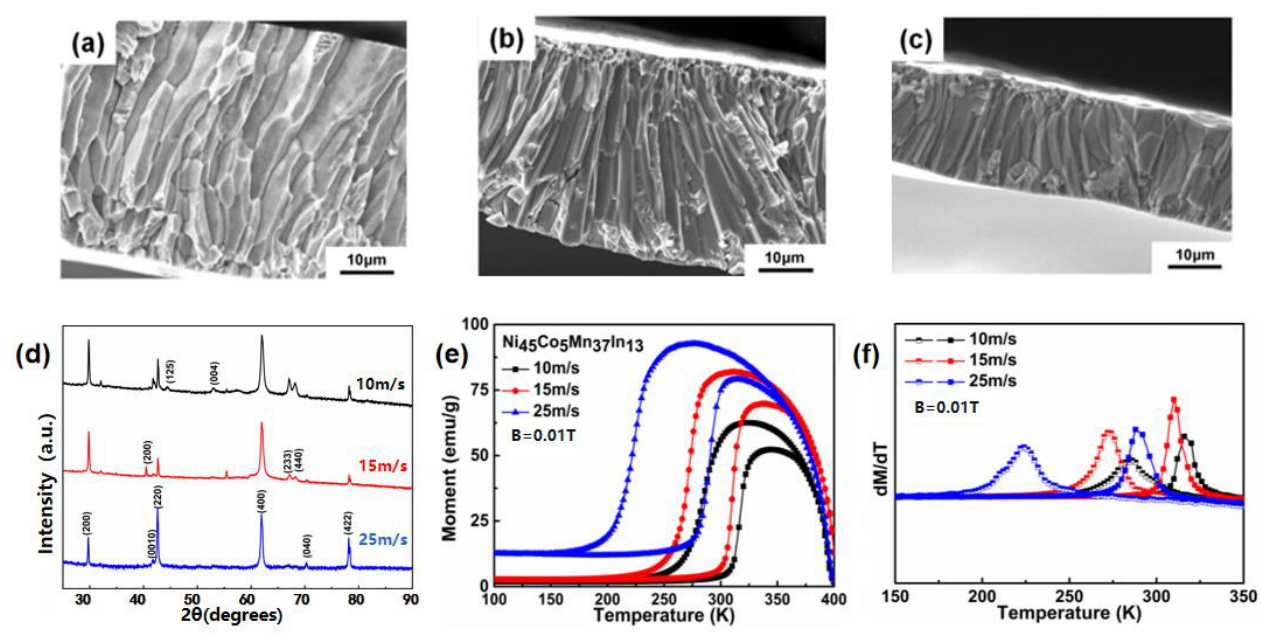
Figure 3. The morphology, crystal structure, and magnetic characterization of the Ni-Co-Mn-In alloy thin ribbons with different wheel speeds (10 m/s, 15 m/s, 25 m/s). SEM ( a – c ), XRD ( d ), M-T ( e ) and dM/dT ( f ).